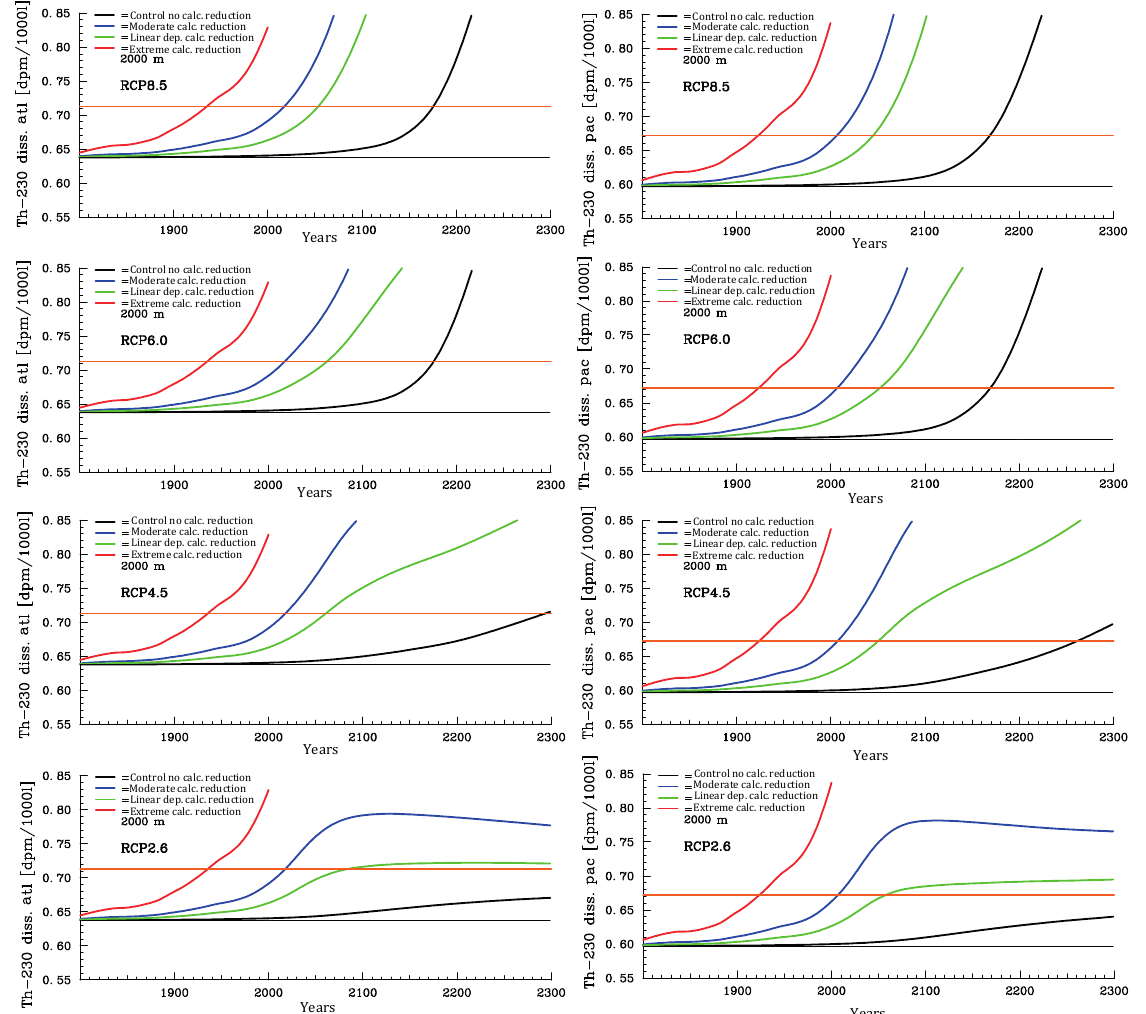
Figure 9. Time series for the evolution of mean Atlantic (left column panels) and Pacific (right column panels) dissolved 230 Th concentrations at 2000m under the different scenarios for reduction of calcification under high CO 2 (unit: dpm/1000L). From top to bottom for greenhouse gas scenarios RCP8.5. RCP 6.0, RCP4.5, and RCP2.6. The orange line indicates the theoretical detection limit for changes with respect to the pre-industrial limit. (Respective diagrams for depth levels 700 and 4000m are given in Figs. S3 and